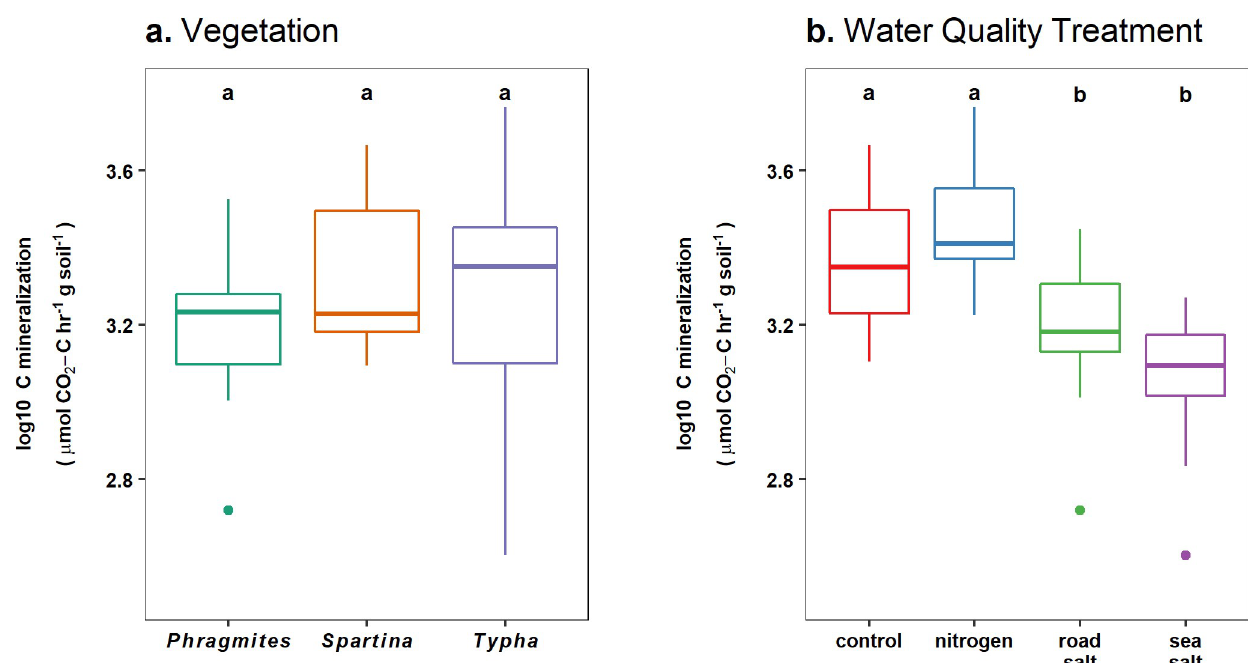
Fig 4. Carbon mineralization rates by vegetation and water quality treatments. Log-transformed sediment C mineralization rates estimated using 24-hour laboratory incubations did not differ among (a) vegetation, but differed among (b) water quality treatments. Differences between groups are indicated by non-overlap of letters, based on post-hoc Tukey